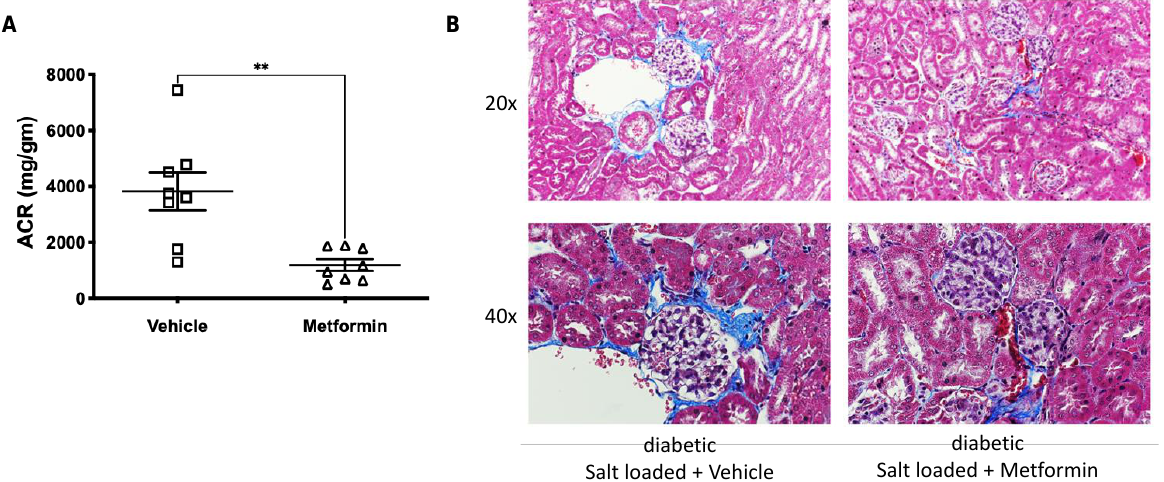
Figure 3. Metformin delays onset on glomerular injury in db/db mice on an HSD. ( A ) Glomerular injury as indicated by microalbuminuria (ACR) in diabetic db/db mice maintained on an HSD and treated with vehicle or metformin: ** p < 0.01. ( B ) Renal histology (H & E) and trichrome staining show glomerular hypertrophy and hypercellularity in the vehicle-treated mice. These pathological changes were reduced by metformin